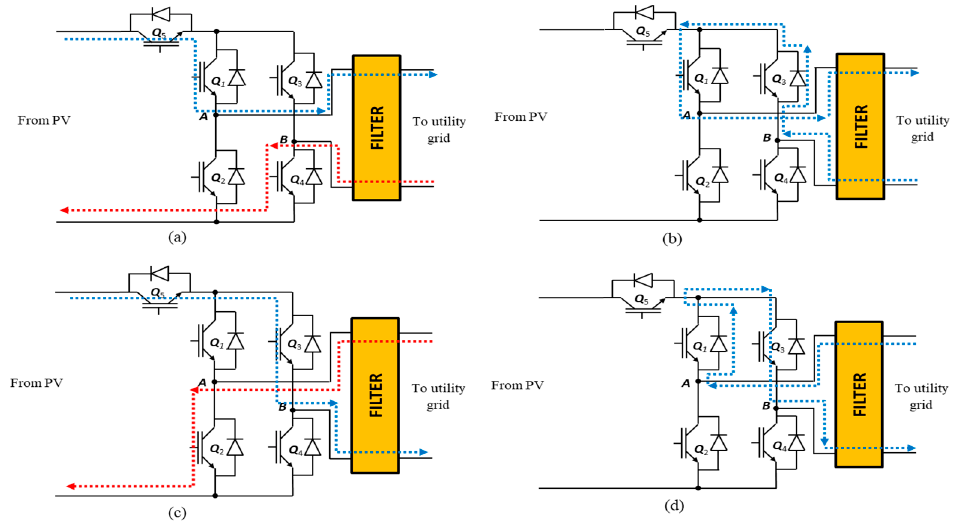
Figure 3. H5 inverter modes of operation ( a ) mode 1, ( b ) mode 2, ( c ) mode 3 and ( d ) mode 4.